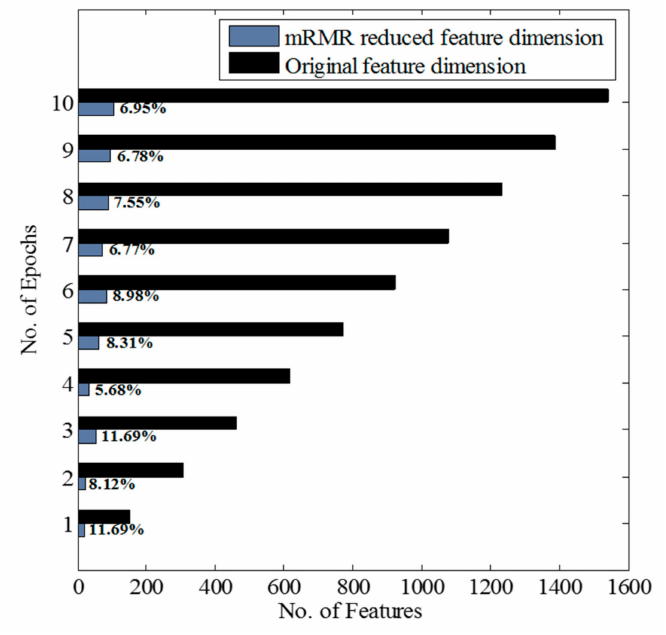
Figure 4. Feature dimension reduction using the mRMR